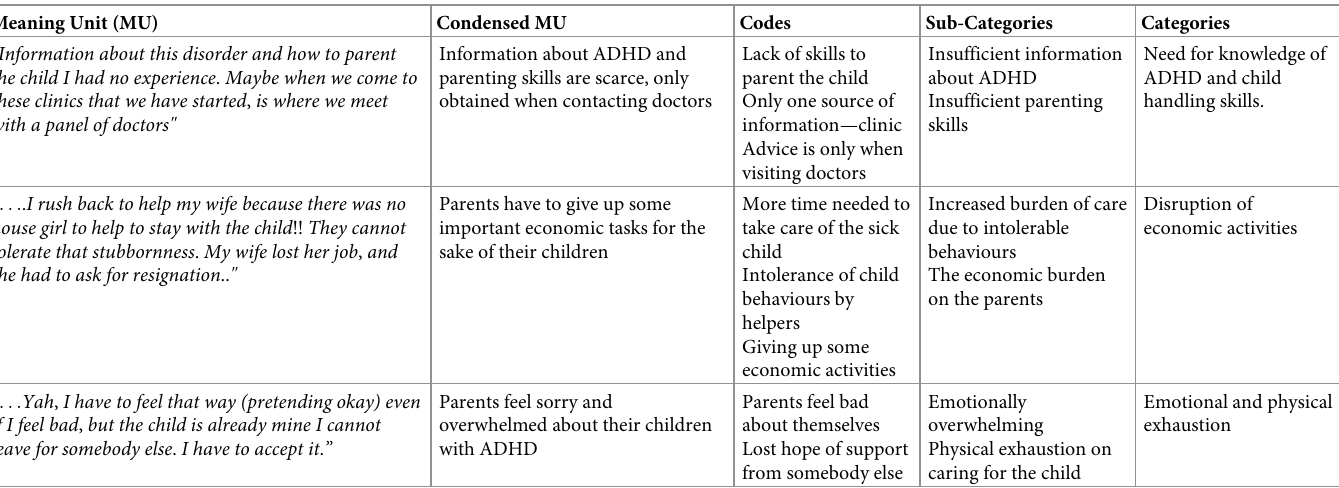
Table 2. Examples of formation of categories during the analysis.